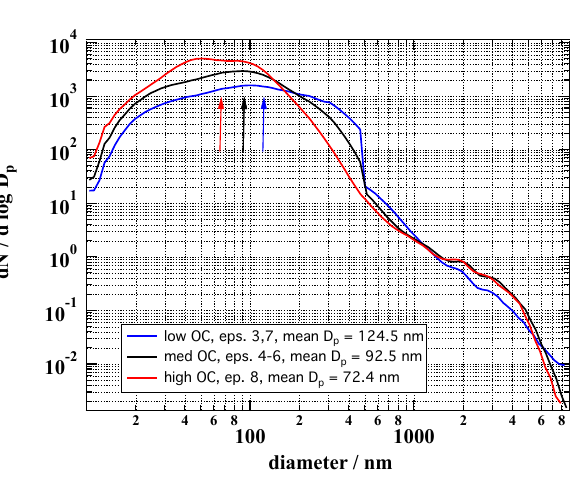
Fig. 3. Particle number size distribution measured with SMPS and APS systems during CAPMEX. The mean particle diameters cal- culated from the number distributions are 72.4nm, 92.5nm, and 124.5nm for the high, intermediate, and low OC/SO 2 − and their locations in the number distribution are shown by the color-coded